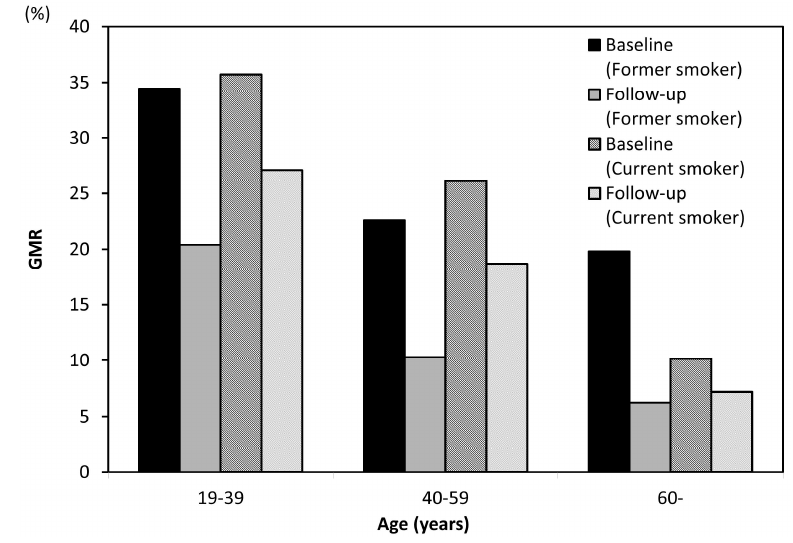
Figure 4. Mean GMR scores of former smokers vs. current smokers at baseline and follow-up.